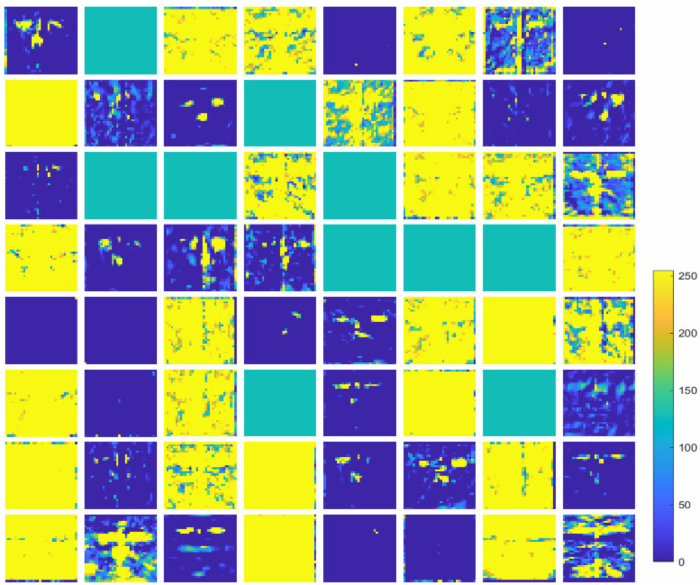
Figure 11. Feature visualization of the first layer of 3D CNN